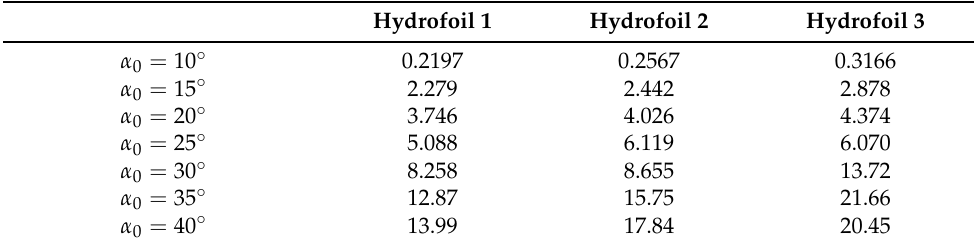
Table 5. Power extraction efficiency η (%) for f ∗ = 0.025, ∆ h = 0.8 m, and for the three